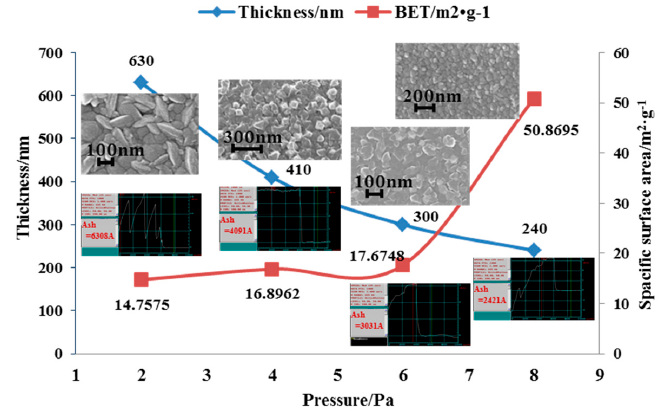
Figure 7. The effects of different sputtering parameters on the specific surface area and thickness of the films.